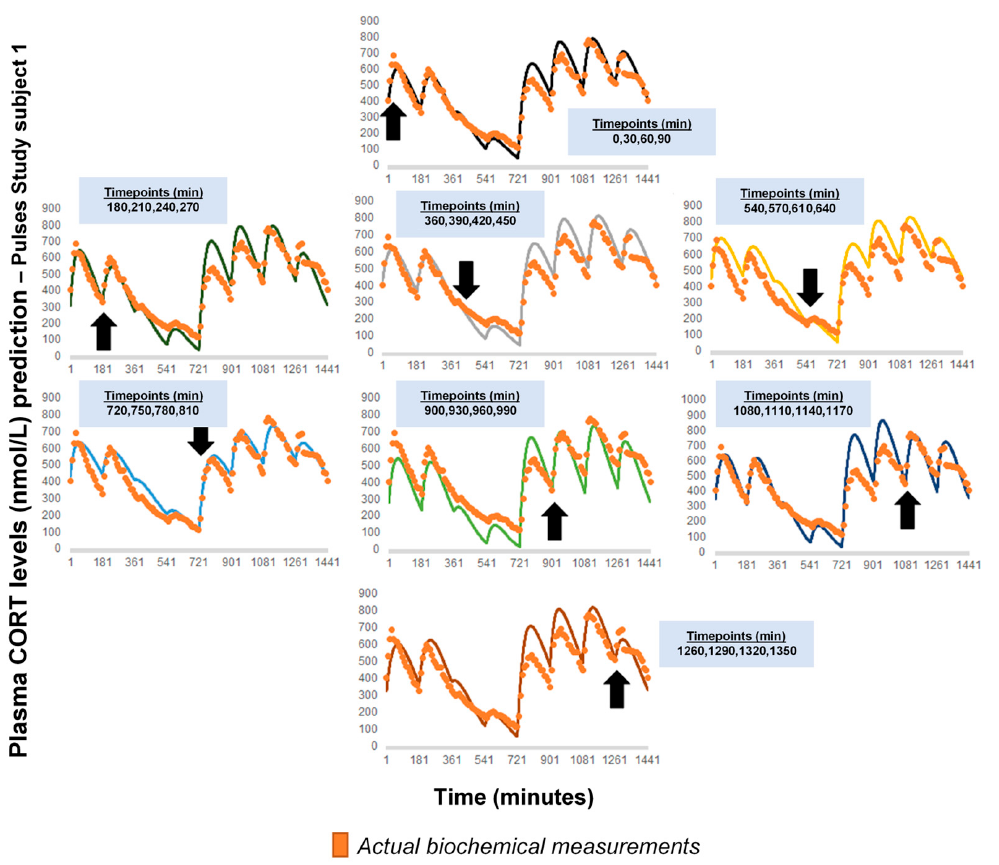
Figure A1. Comparison of the revised model predictions with plasma CORT data, if calculation of the initial pair of (k, k α ) was based on another set of four CORT time point measurements. The time distance between the four CORT measurements was retained (t0, t0 + 30 min, t0 + 60 min, and t0 + 90 min), but each initial time t0 was shifted by 3 h (black arrows and light blue frames). The data from the Pulses study Subject 1 was used (see Materials and Methods). CORT: cortisol, k: clearance rate, k α : absorption rate. Time points of delivery (magnitude of doses): 0 min (2.3 mg/230 µ L), 180 min (2.3 mg/230 µ L), 360 min (0.5 mg/50 µ L), 540 min (0.5 mg/50 µ L), 720 min (4 mg/400 µ L), 900 min (4 mg/400 µ L), 1080 min (4 mg/400 µ L), 1260 min (2.3 mg/230 µ L). The orange dots in the diagrams represent the actual plasma cortisol measurements (which are the same in all cases), and the continuous lines (of varying colours) represent the model predictions (which slightly change depending on the set of four CORT measurements, which the calculations were based on).